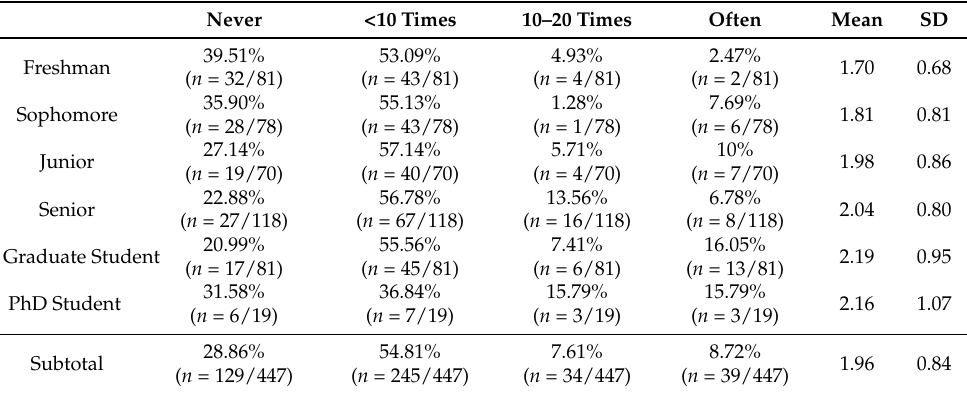
Table 4. Frequency of student engagement in outsourcing their coursework from electronic resources (Baidu Library, ZhifouUniversity App, file-sharing sites, peer-sharing sites, essay factories, etc.) by year of